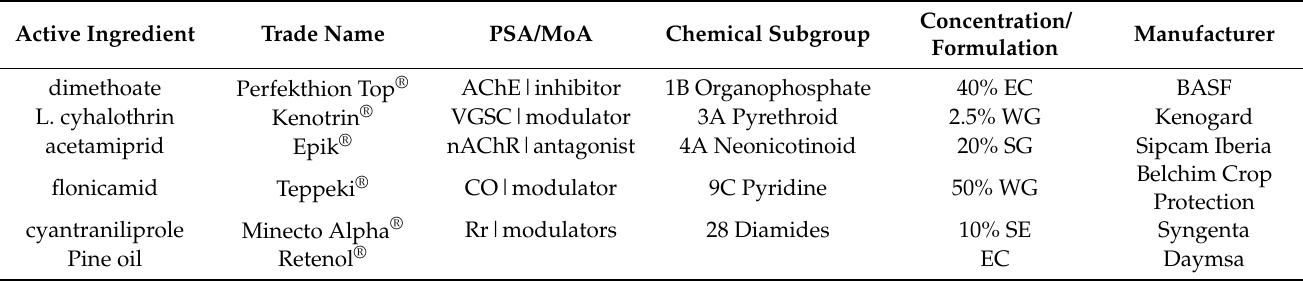
Table 1. Insecticides and adjuvant screened in this